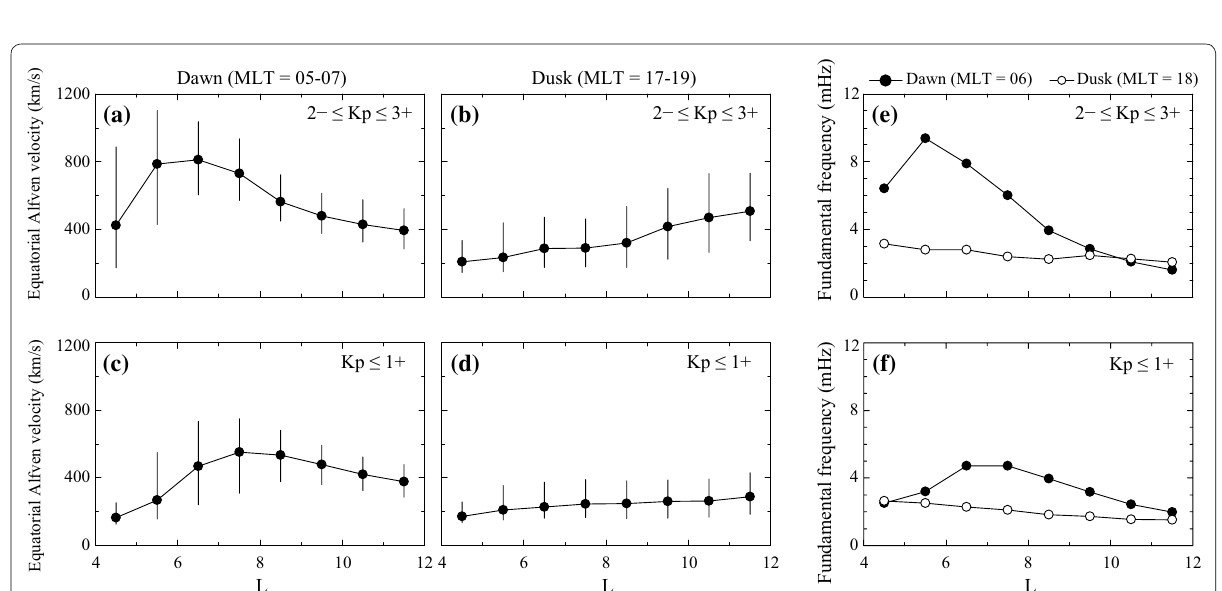
Fig. 5 a – d The L profiles of V A medians obtained on the dawnside (MLT m 3 amu under moderate and quiet conditions. The dots connected by a straight line indicate the V A medians, and the vertical bars connect the = lower and upper quartiles. e – f The fundamental toroidal Alfvén frequencies at dawn and dusk under moderate and quiet geomagnetic